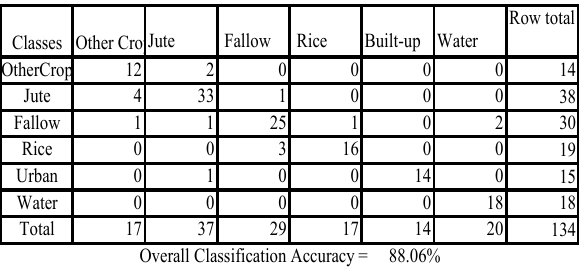
Table 2: Confusion Matrix for Murshidabad district of West Bengal